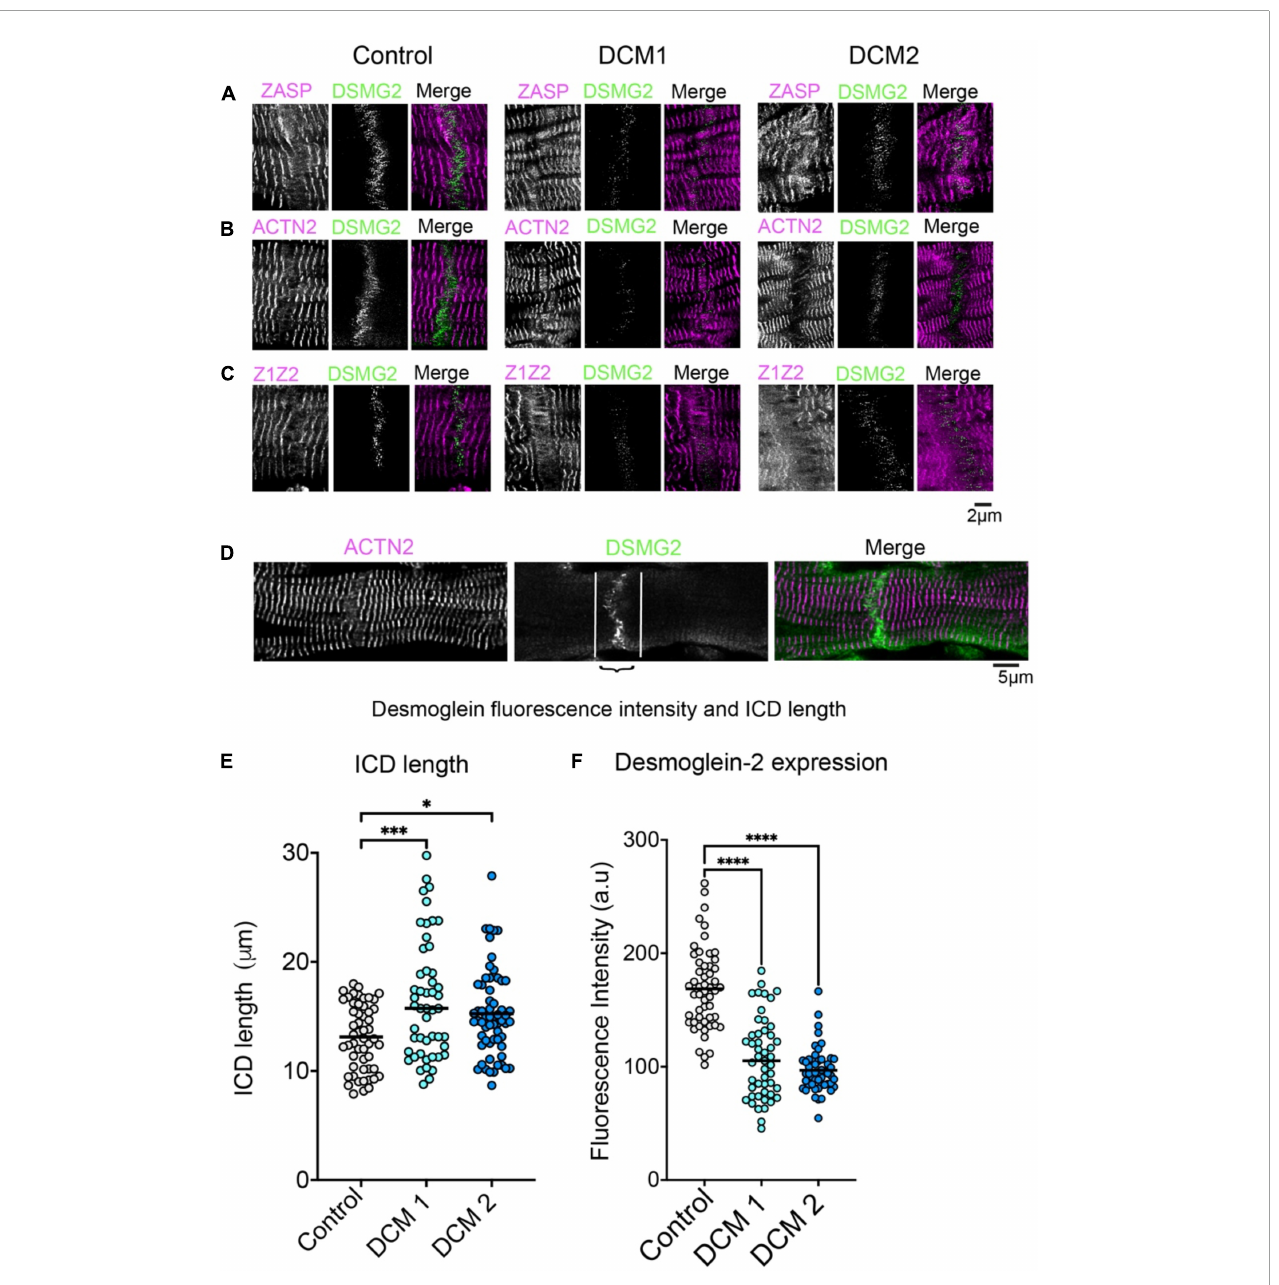
FIGURE3 Labelling of intercalated discs (ICDs) between cardiomyocytes in heart tissue sections with Z-disc Affimers and desmoglein. Panels (A–C) are examples of labelling for ZASP (A) , ACTN2 (B) and titin Z1Z2 (C) for control (normal donor heart) and DCM heart tissue sections. Panel (D) shows desmoglein staining for a single ICD in more detail to show the region of interest used to estimate labelling intensity for desmoglein (DSMG2) in the ICD. Panel (E) shows the average length of the ICD and (F) the fluorescence labelling intensity for desmogelin staining, for controls and DCM patients. A minimum of 50 ICDs were analysed for three independently stained heart tissue sections. ∗ p < 0.05, ∗∗∗ p < 0.001, ∗∗∗∗ p < 0.0001 for comparisons of DCM 1 and DCM2 to